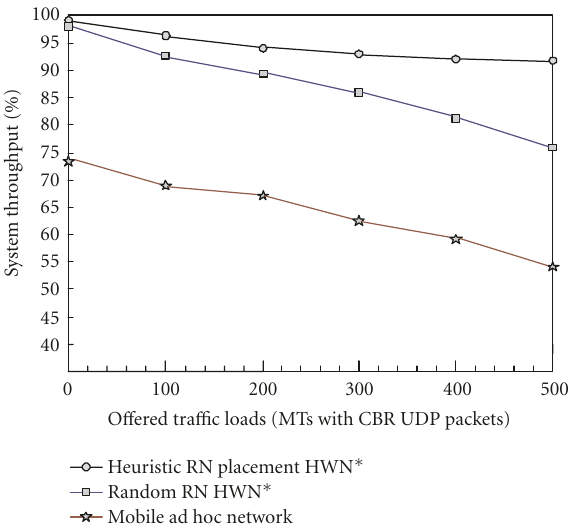
Figure 11: Average end-to-end transmission delay of HWN ∗ , WINNER, and